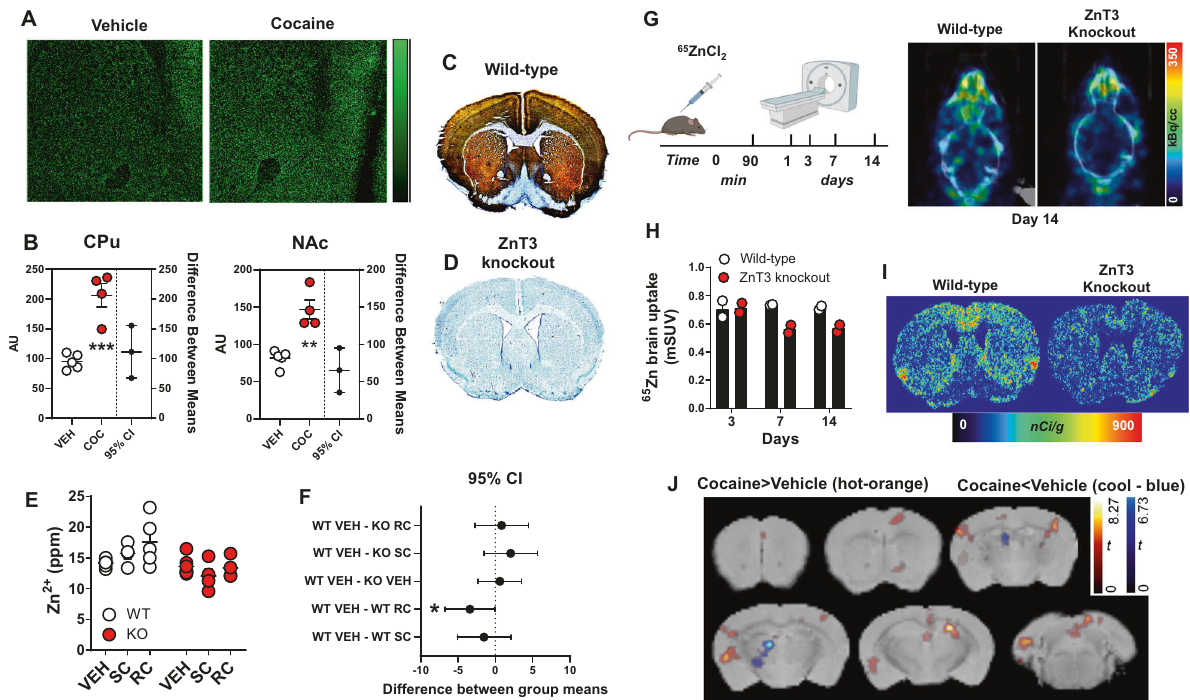
Fig. 2 Cocaine increases synaptic Zn 2 + release and uptake in the striatum. A Representative synchrotron X-ray fl uorescence microspectroscopy (µSXRF) Zn 2 + maps from vehicle- or cocaine-treated mice. B Cocaine-treated mice had signi fi cantly greater Zn 2 + (AU- arbitrary units) than vehicle-treated mice in caudate putamen (CPu) and nucleus accumbens (NAc). C Representative Timm- and cresyl violet- co-stained sections from a wild-type (WT) and D a ZnT3 knockout (KO) mouse. E Zn 2 + content measured using TXRF in wild-type and ZnT3 knockout mice exposed to vehicle (VEH), a single cocaine injection (SC) or repeated cocaine injections (RC) injections. F Wild-type mice exposed to RC had signi fi cantly greater Zn 2 + levels compared to VEH-treated WT mice. G PET experimental timeline and representative horizontal 65 Zn PET/CT images from wild-type and ZnT3 knockout mice scanned at 14 days after 65 ZnCl 2 administration. H 65 ZnCl 2 brain uptake expressed as mean standard uptake value (mSUV) in wild-type and knockout mice scanned at 3, 7 and 14 days after injection. I Representative 65 ZnCl 2 autoradiograms from wild-type and ZnT3 knockout mice scanned using PET at day 15 after 65 ZnCl 2 administration and then euthanized for postmortem veri fi cation. J Statistical contrasts from voxel-wise statistical parametric mapping analyses from vehicle- or cocaine-treated mice exposed to 65 ZnCl 2 PET imaging. ppm parts per million. * p ≤ 0.05, ** p ≤ 0.01, *** p ≤ 0.001. All data expressed as Mean ±